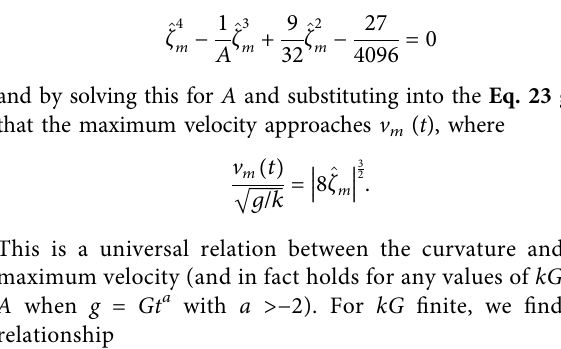
Frontiers in Applied Mathematics and Statistics |